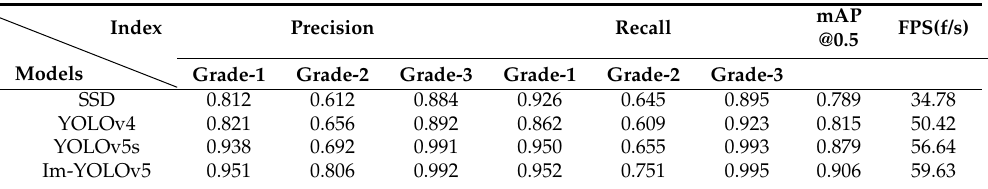
Table 3. Comparison of different models.